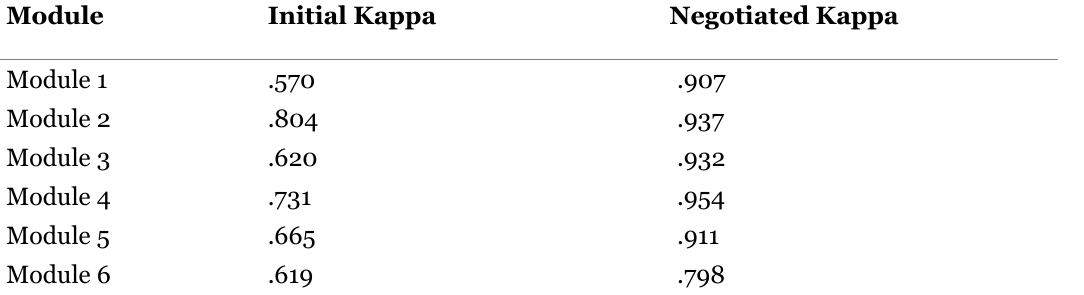
Inter-rater Reliability Measures: Cohen’s